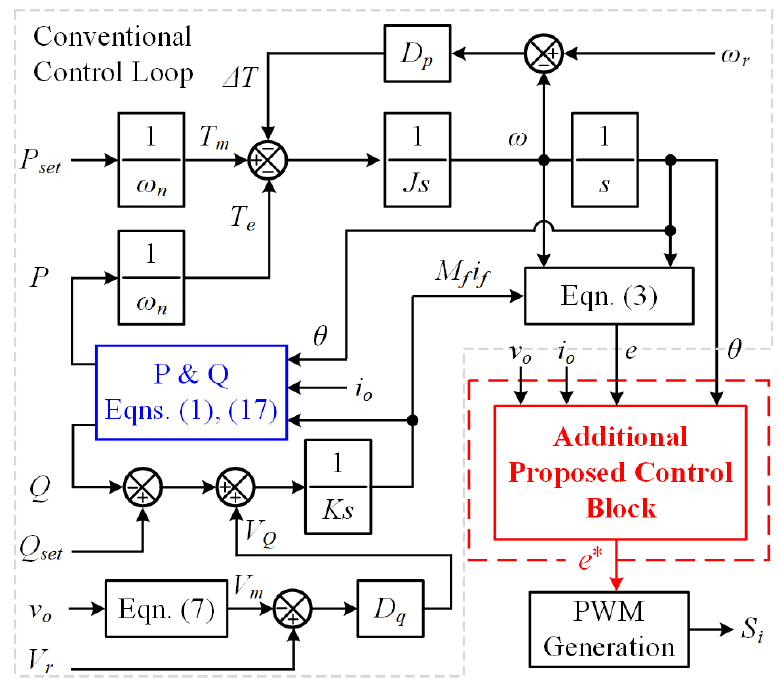
Figure 5. Proposed control block diagram for enhancing the synchronverter dynamics from SAM to GCM